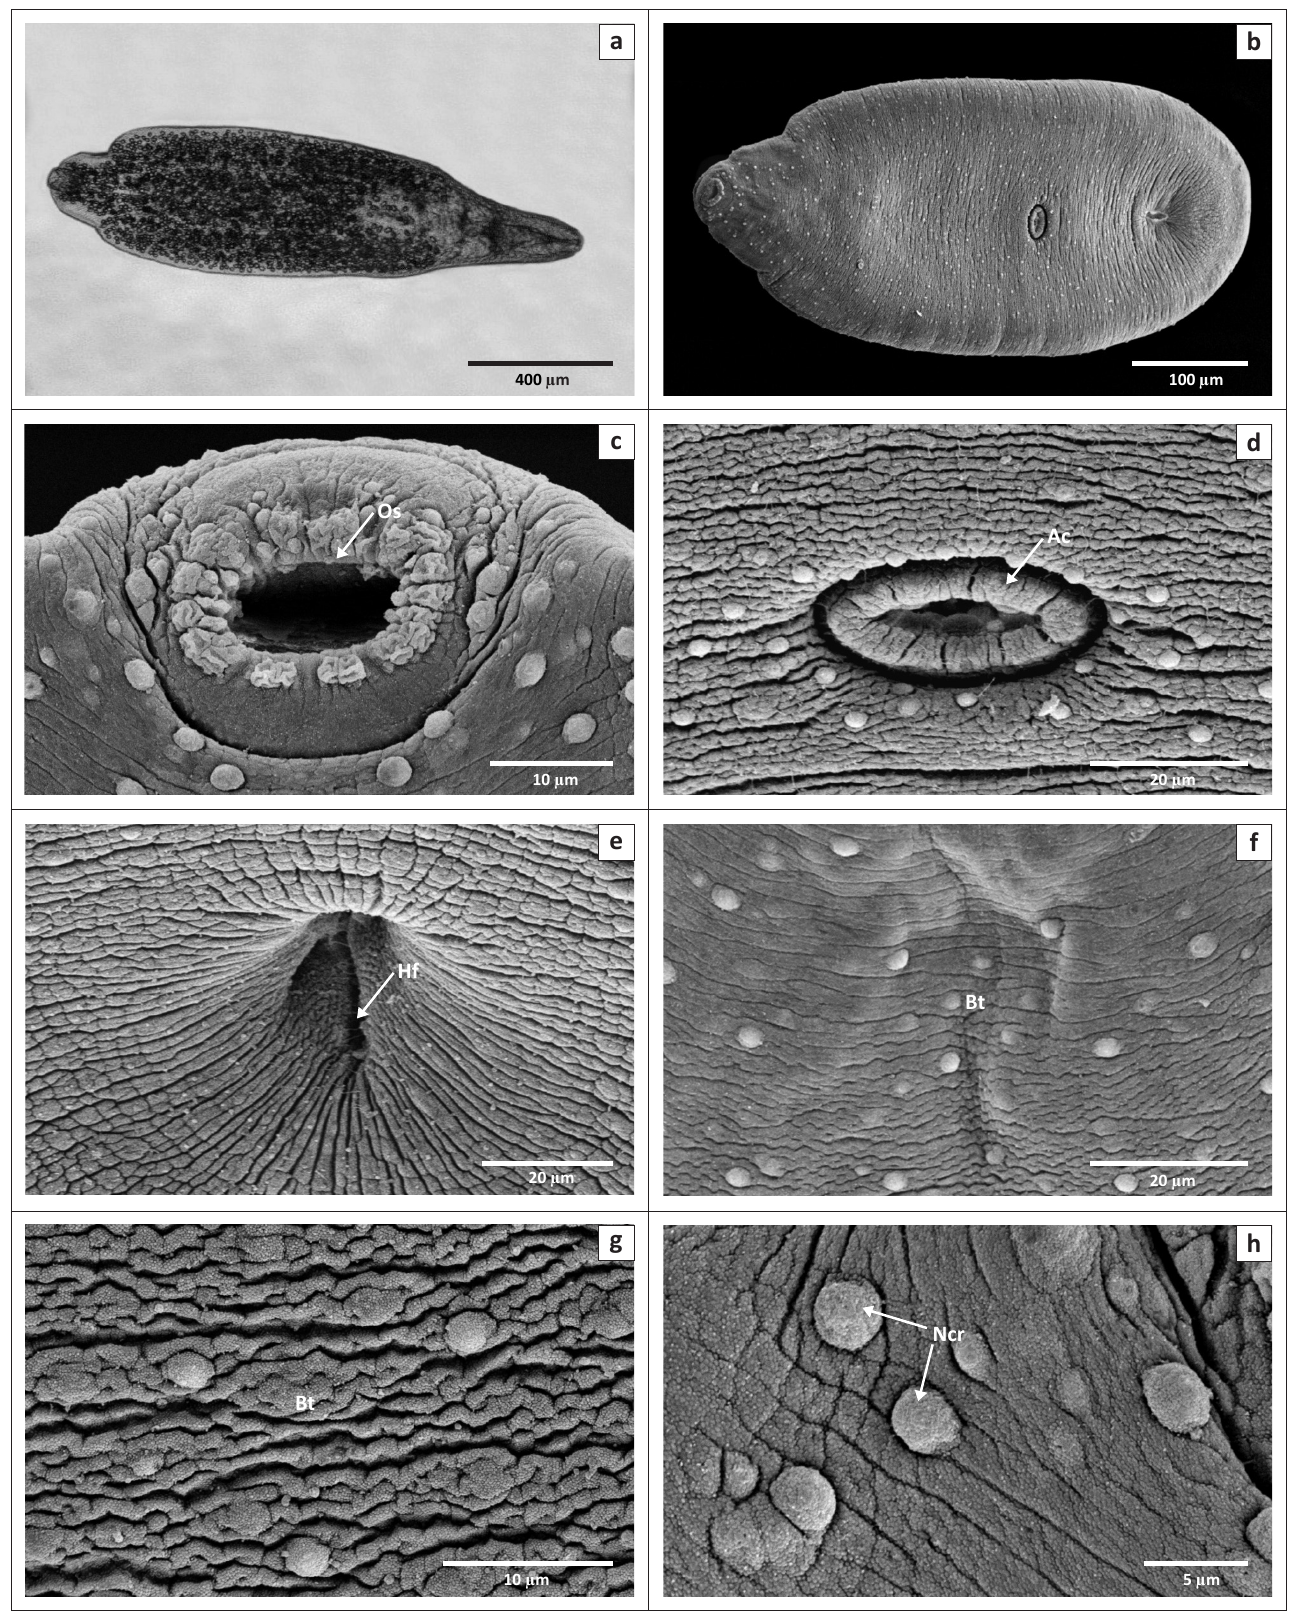
Note: Figure b–h are scanning electron micrographs of Diplostomid metacercaria A [ Diplostomulum ( Tylodelphys ) mashonense ] from the cranial cavity of Clarias gariepinus collected from Boekenhoutskloof farm dam, Gauteng Province. Host: Clarias gariepinus. Preferred site in the host: brain cavity. Locality: Boekenhoutskloof farm Dam, Gauteng Province Os, Oral sucker; Ac, Acetabulum; Hf, Holdfast organ; Bt, body tegument; Ncr, Non-ciliated receptors FIGURE 2: Light and scanning electron micrograph, (a) Light micrograph, (b) Whole mount, (c) Oral sucker, (d) Acetabulum, (e) Holdfast organ, (f) Anterior body tegument, (g) Body tegument at the acetabular region and (h) Non-ciliated receptors on body